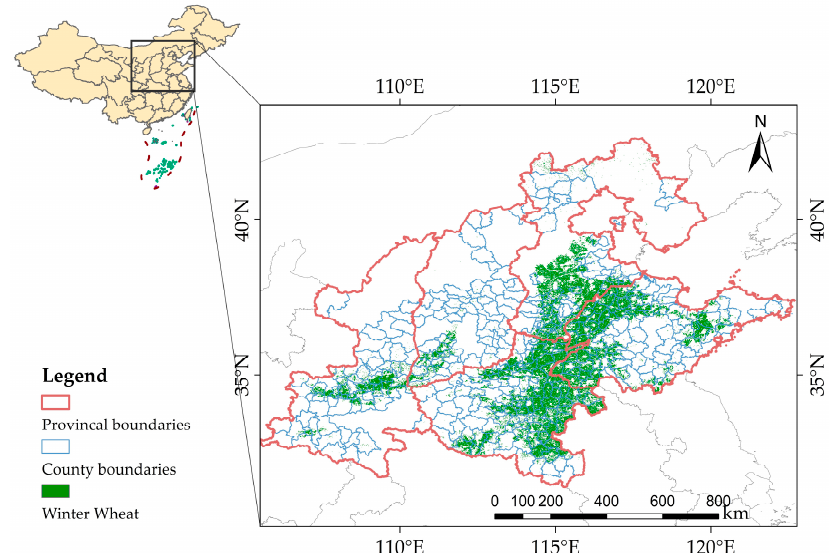
Figure 1. The spatial distribution of winter-wheat-planting areas in Northern China.